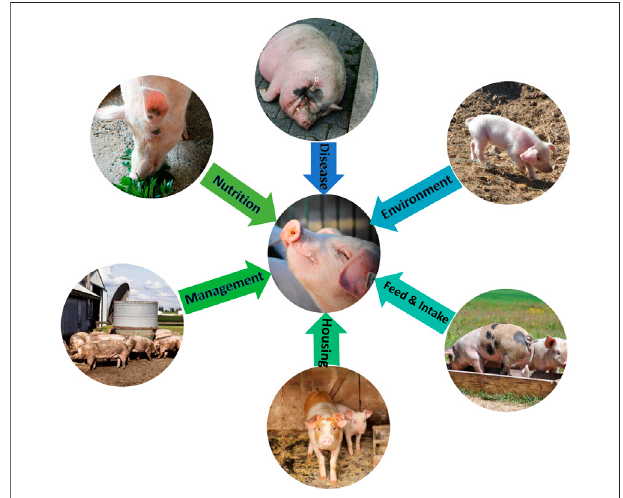
FIGURE 1 | Non-genetic factors affecting feed ef fi ciency traits in swine industry. All pictures were taken from public-domain share-free